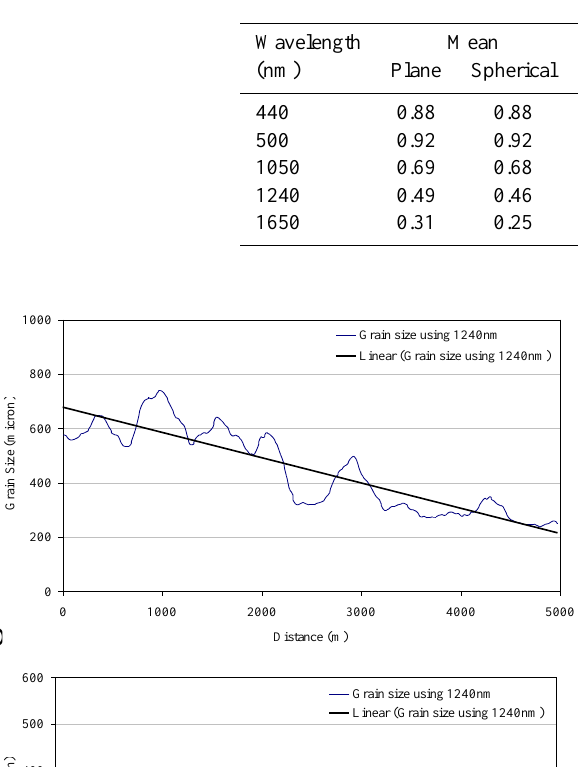
Table 9. Spectral plane and spherical albedo of upper Himalayan zone with SZA: 58.5 ◦ .